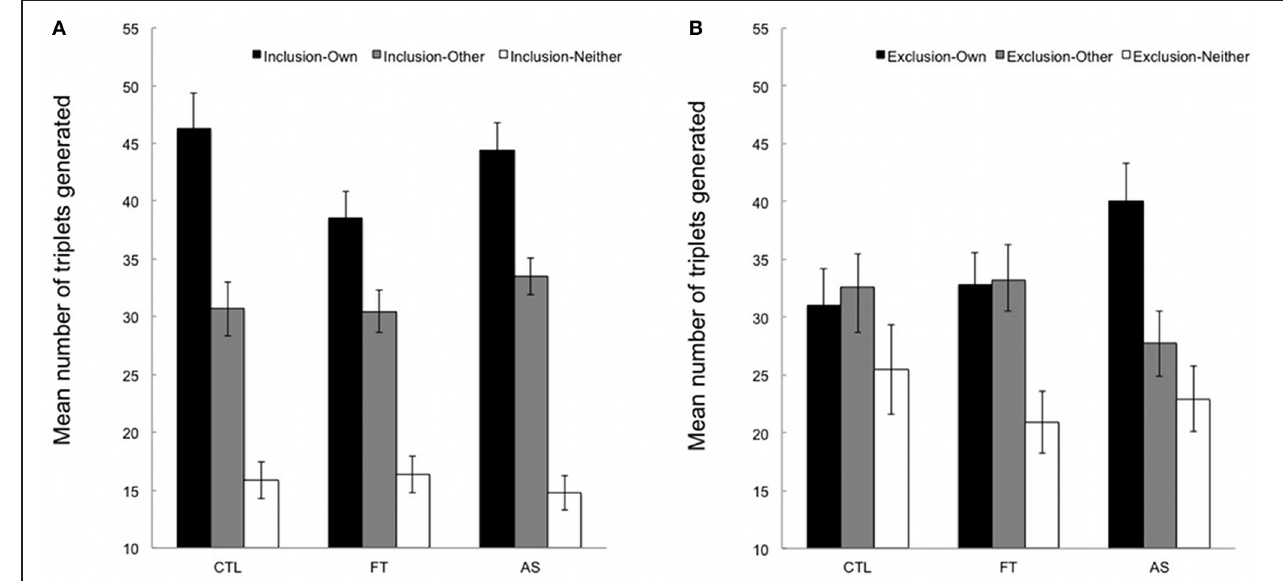
FIGURE 2 | (A) Mean number of triplets generated in inclusion under articulatory suppression (AS), foot tapping (FT), and control (CTL) conditions. “Own”, number of SOC triplets generated from the training sequence; “other”, number of triplets from the alternate, untrained sequence; neither, number of triplets from neither the training nor the untrained sequence. Error bars represent standard errors. (B) Mean number of triplets